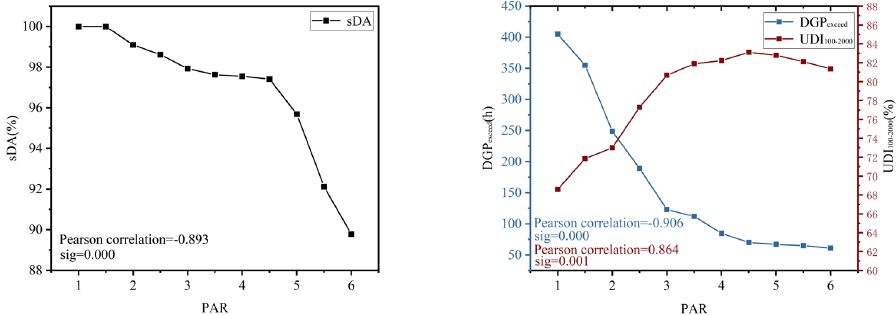
Figure 12. Analysis of plan aspect ratio simulation results.